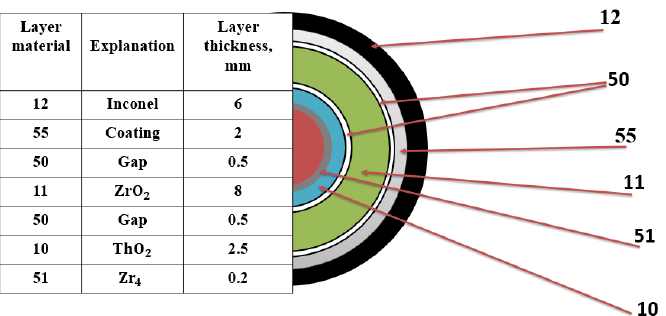
Figure 6. Radial nodalization of SCDAP shroud component, which corresponds to PHEBUS FPT-1 test shroud layers.